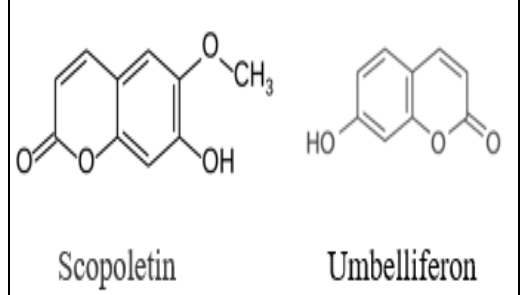
Figure 6. Chemical structure of β – sitosterol(phytosterol) (47).